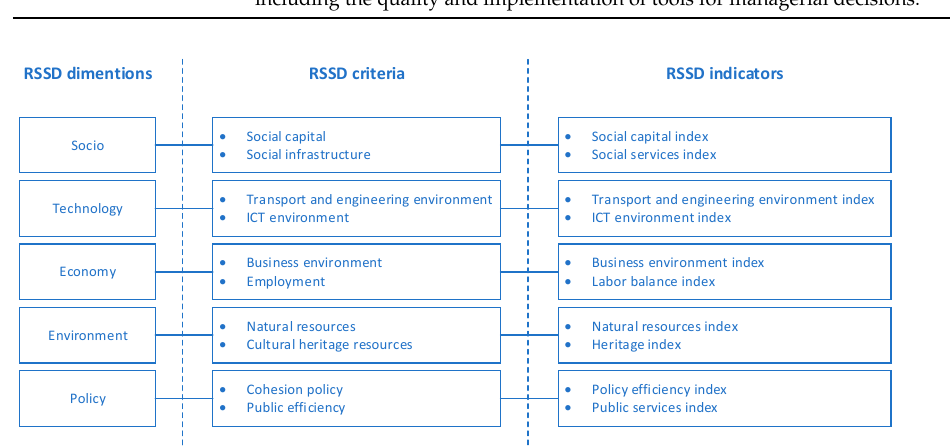
Figure 6. Preliminary Conceptual Framework of RSS.